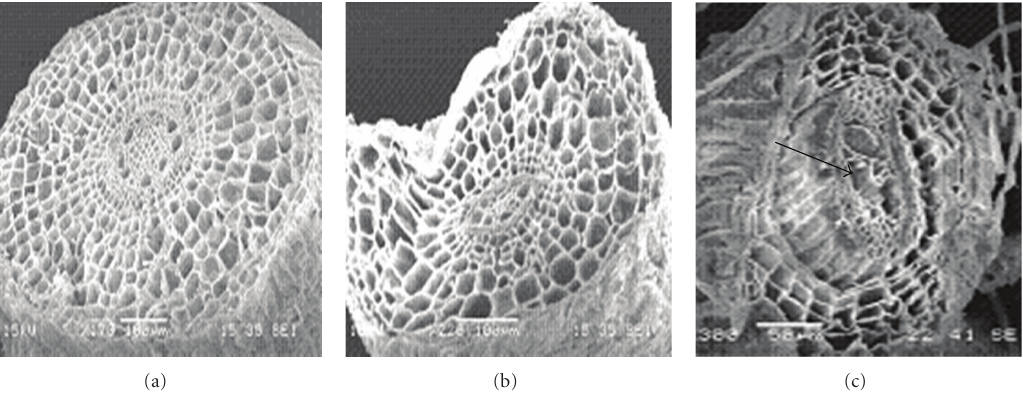
Figure 8: Scanning electron microscopy photographs showing root cortical tissue of Digitaria didactyla under (a) 0, (b) 24, and (c) 48dSm − 1 . The arrow indicates cell damage (c) compared to control